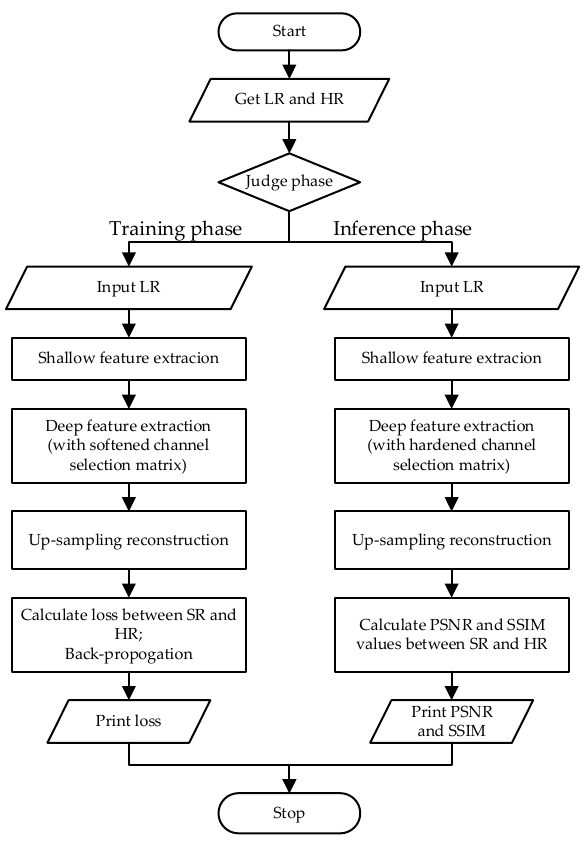
Figure 4. The flowchart of our proposed SCPN methodology.